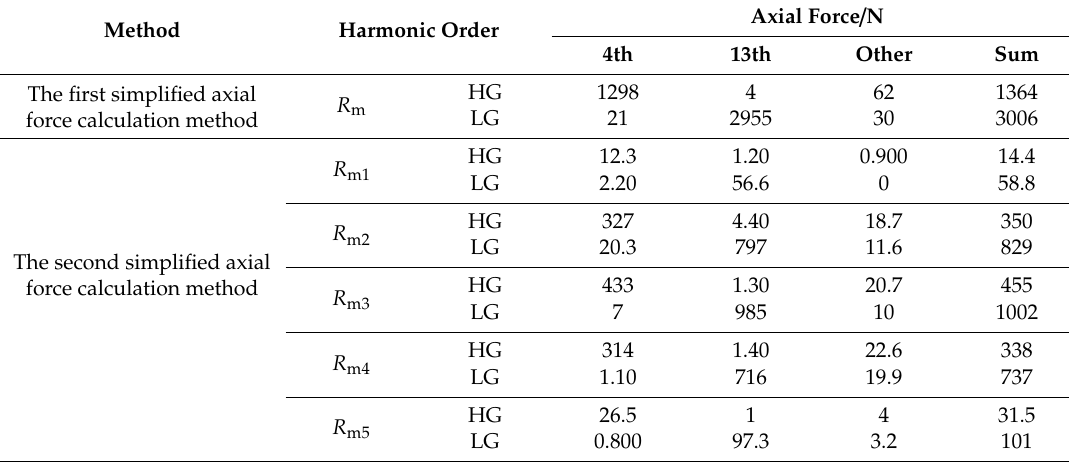
Table 5. Axial force at di ff erent radii by the first or second simplified axial force calculation method. Method Harmonic